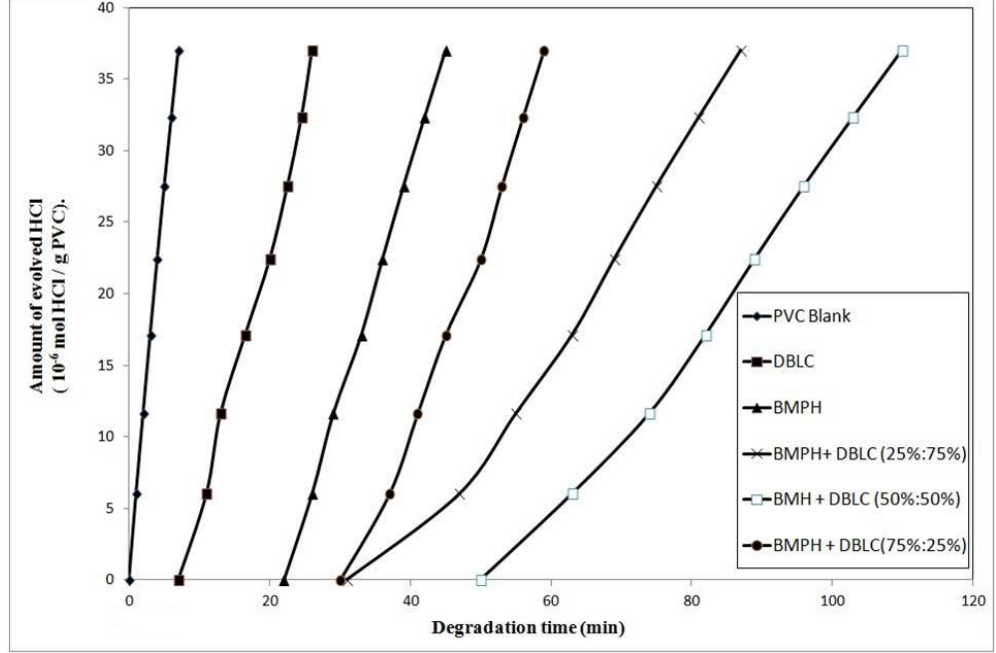
Figure 5. Dehydrochlorination rate of rigid PVC (BMPH stabilizer was mixed with DBLC), at 180 °C, in air, in the presence of 2 mass % of mixed